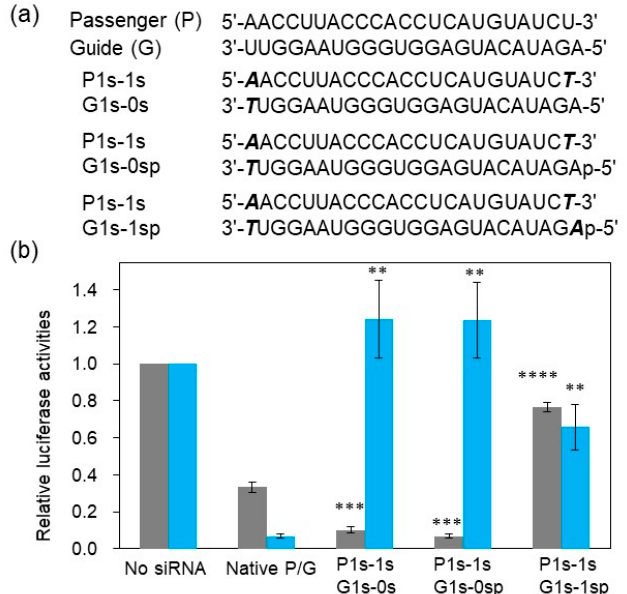
Figure 3. RNA interference (RNAi) activities of SNA-modified siRNAs. ( a ) siRNAs used in the luciferase assay. The upper strand is the passenger strand (P) and the lower strand is the guide strand (G). Bold, italic characters indicate SNA and p denotes 5’ phosphate. ( b ) RNAi activities of the guide strands (grey bars) and passenger strands (cyan bars) evaluated using reporter plasmids pGL3-On and pGL3-Off, respectively. Plotted are means and SD ( n = 3) of firefly /Renilla luciferase signal relative to the untreated sample. ** p < 0.01, *** p < 0.001, **** p < 0.0001 vs. native P/G.